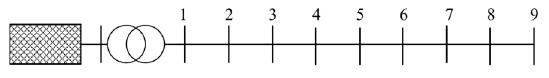
Figure 19. Current waveform of branch 5–6 before and after compensation by filters.